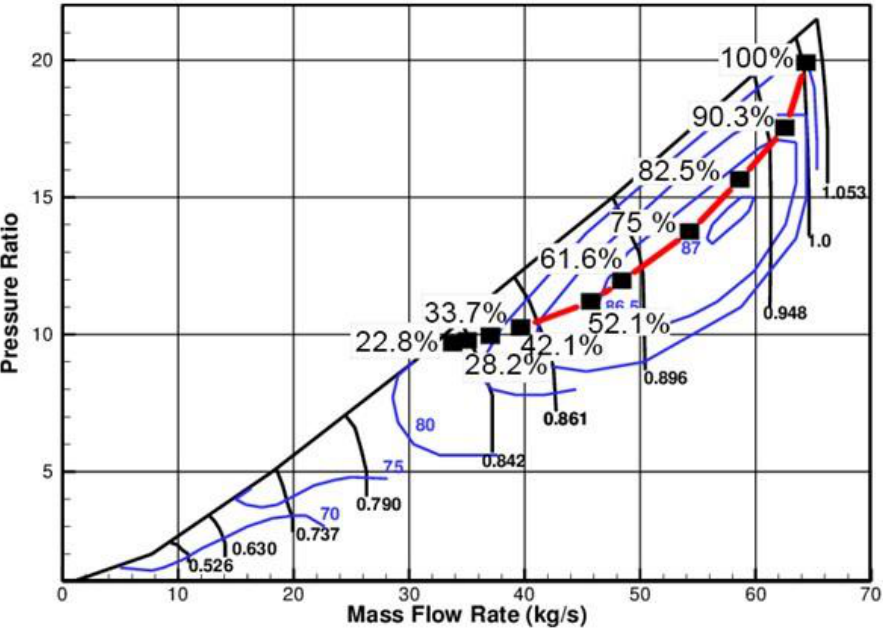
Figure 6. Plot curve performance of the LM 2500 gas turbine compressor against variations in loading from the system.